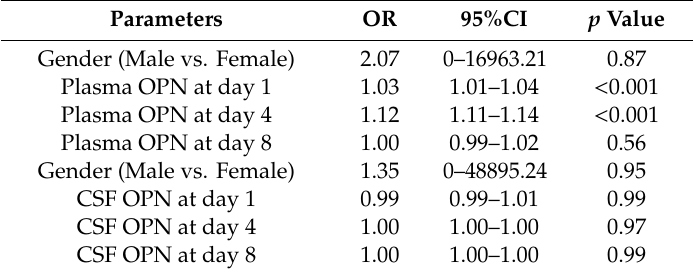
Table 2. Odds ratio (OR) of poor prognosis at 3 months. Osteopontin plasma concentration and gender as predictors (upper table); CSF OPN concentration as predictor (lower